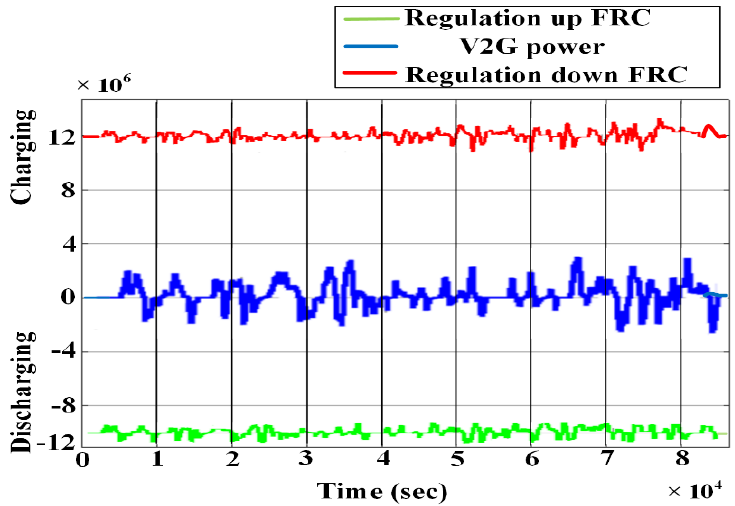
Figure 16. EV V2G power and total frequency regulation capacity (FRC), resulting in ACE suppression.